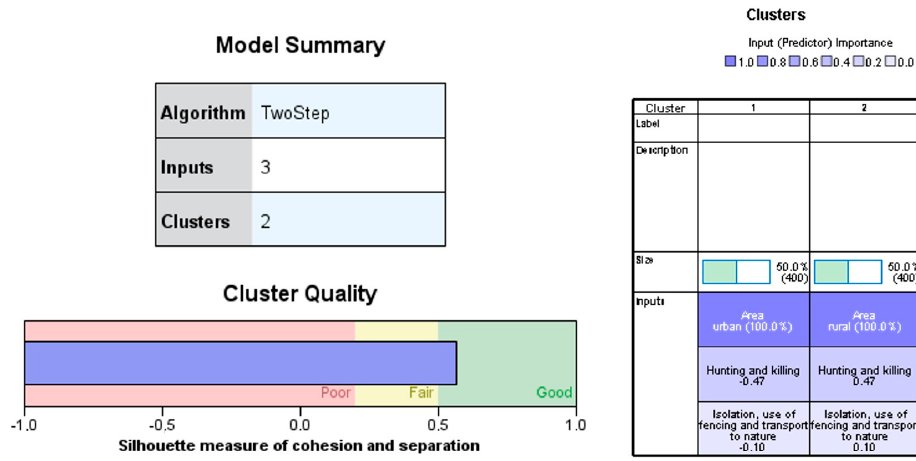
Figure 7. Diagrammatic results of the two-step cluster analysis’s acceptance.